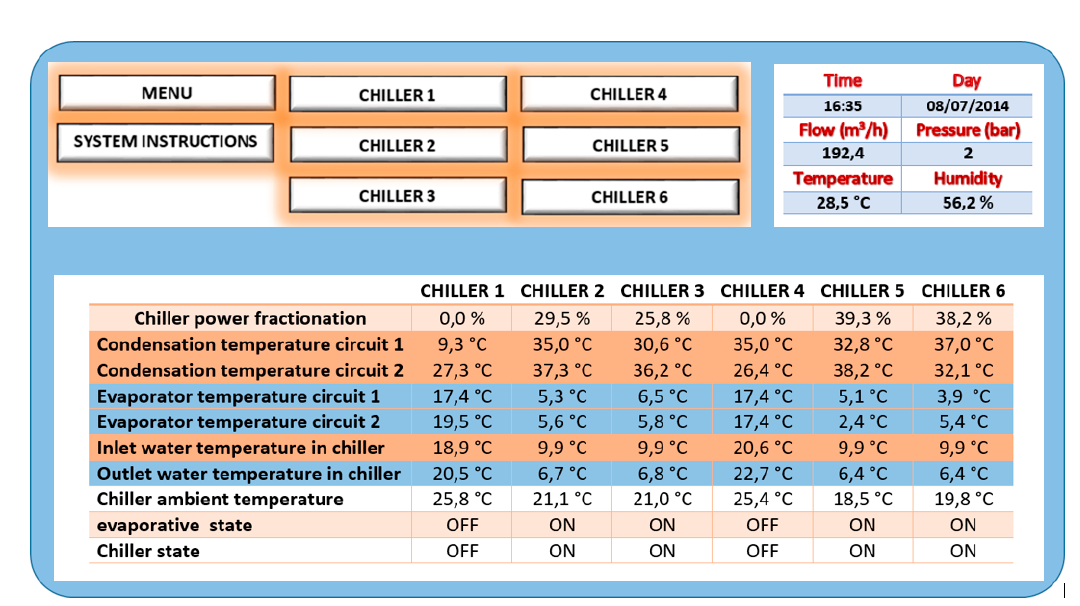
Figure 2. Screenshot of the Control System of the chiller plant.